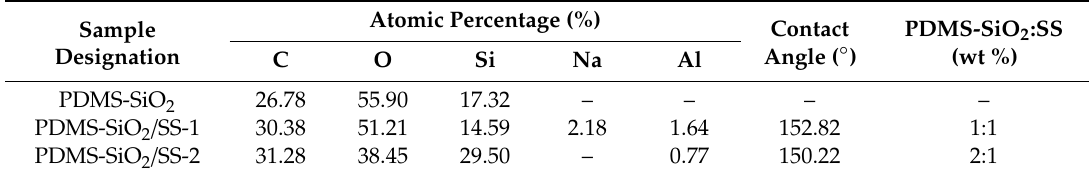
Table 1. Contact angle, atomic percentage of C, O, Si Na, Al, of PDMS-SiO 2 and PDMS-SiO 2 / SS samples, according to EDS data.